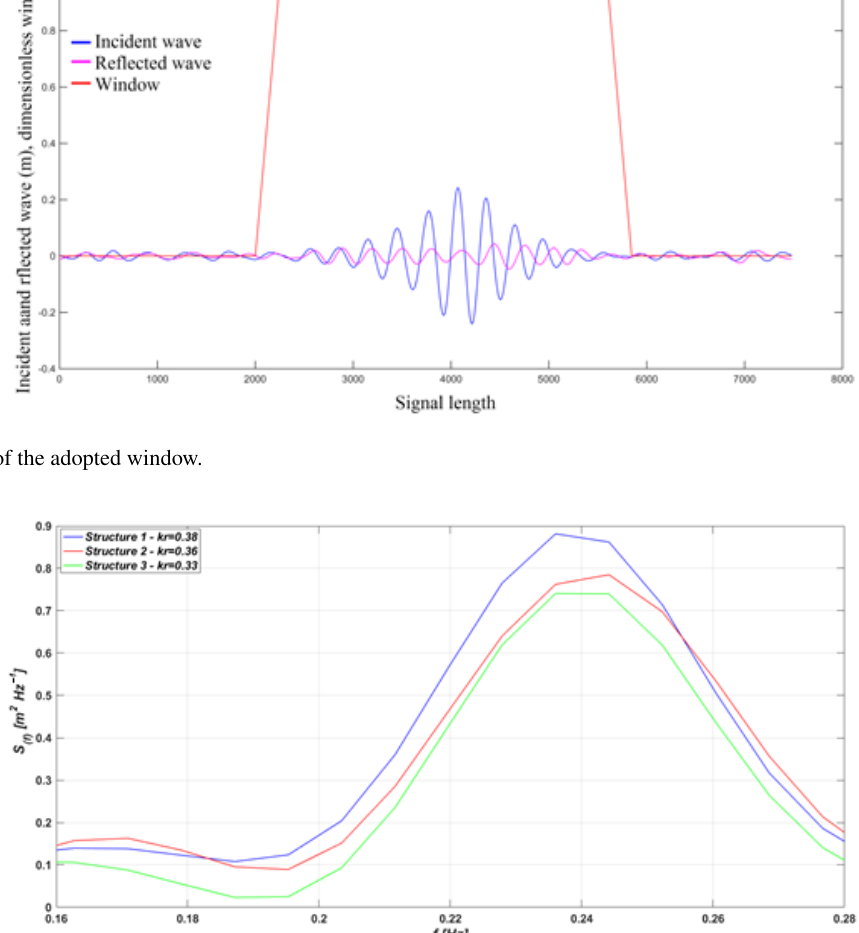
Figure 16. Comparison of reflected wave spectrums for wave no.